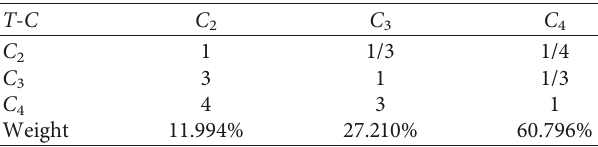
Figure 5: Membership function for the evaluation indices. (a) Existing building. (b) Underground pipelines. (c) Propulsion speed. (d) Rotation speed of the cutter head. (e) Grouting pressure. (f) Total thrust. (g) Main drive torque. (h) Grouting ability. (i) Number of muck improvement openings. (j) Slagging quantity of the screw Table 10: Judgement matrix of the target layer to the rule layer ( T - C ).